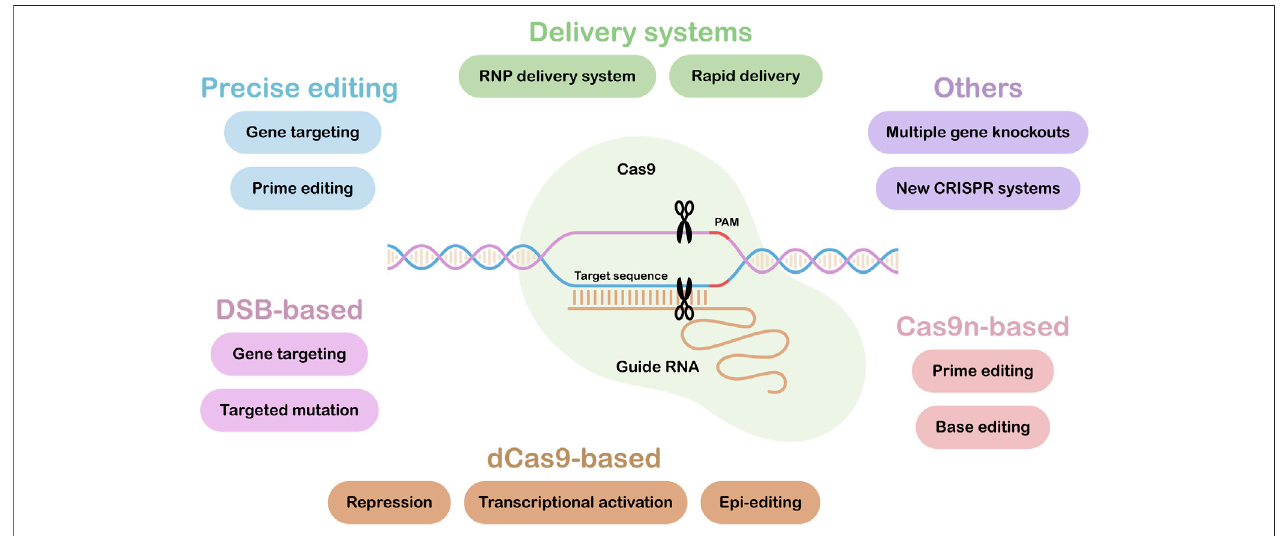
FIGURE 1 | CRISPR/Cas Tools and Resources. Tools and Resources under the headings: Precise editing, Delivery systems and Others are covered in this research topic. The lower part of the fi gure summarizes current Cas9-based tools and applications. DSB, Double Strand Break; dCas9, dead or inactive Cas9; Cas9n, Cas9